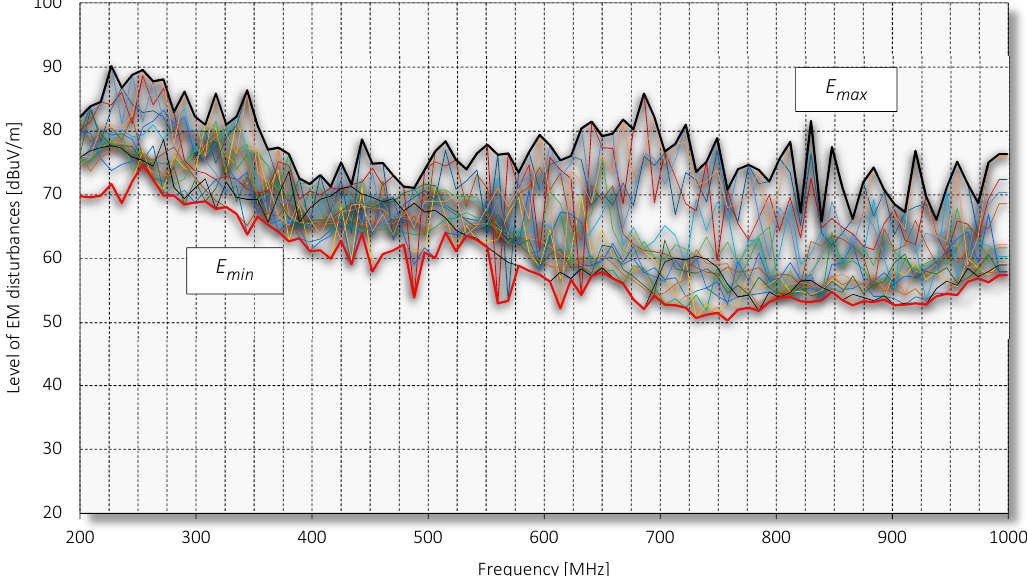
Figure 8. Levels of electromagnetic disturbances (valuable emissions, 15 measured devices of the same type) measured for desktops A in the range of frequencies from 200 MHz to 1 GHz, BW = 50 MHz, measurement distance: 1 m.